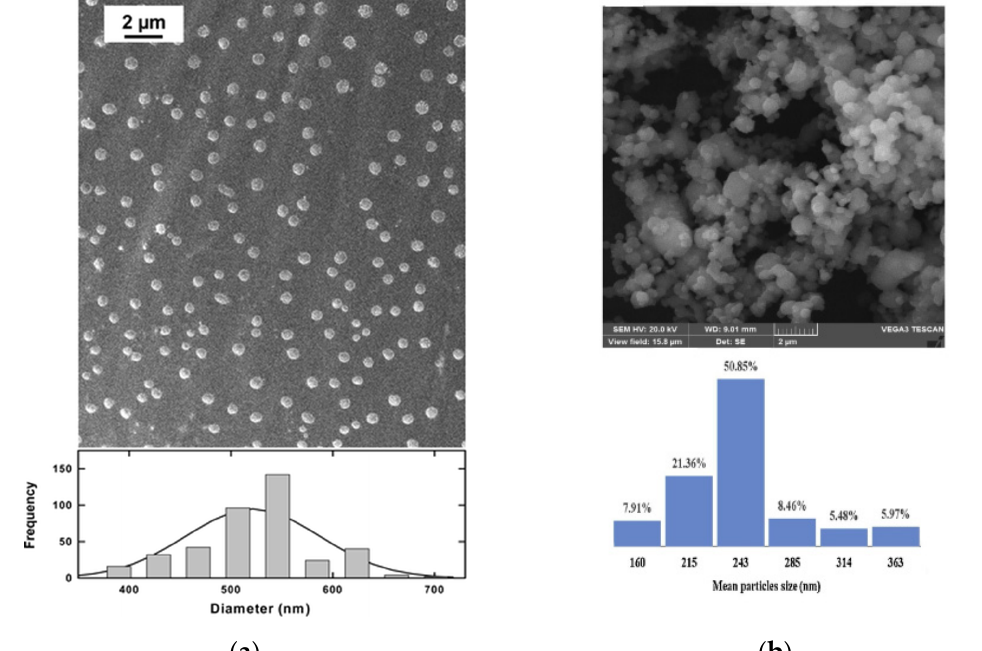
Figure 1. Exemplificative FESEM images and particle size distributions of nanoparticles obtained using scCO2. ( a ) Paclitaxel processed by the RESOLV process. Reprinted with permission from [57]. Copyright © 2022 American Chemical Society. ( b ) Capecitabine nanoparticles obtained by the GAS process. Adapted with permission from [61]. Copyright © 2022